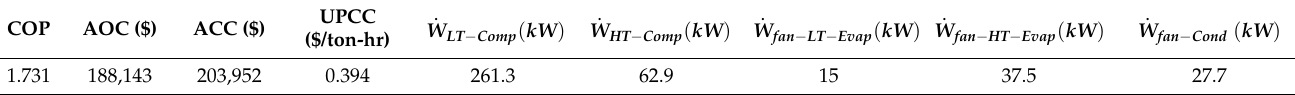
Table 7. Thermodynamic and economic results for the optimized cycle using R170-R161 refrigerant pair.